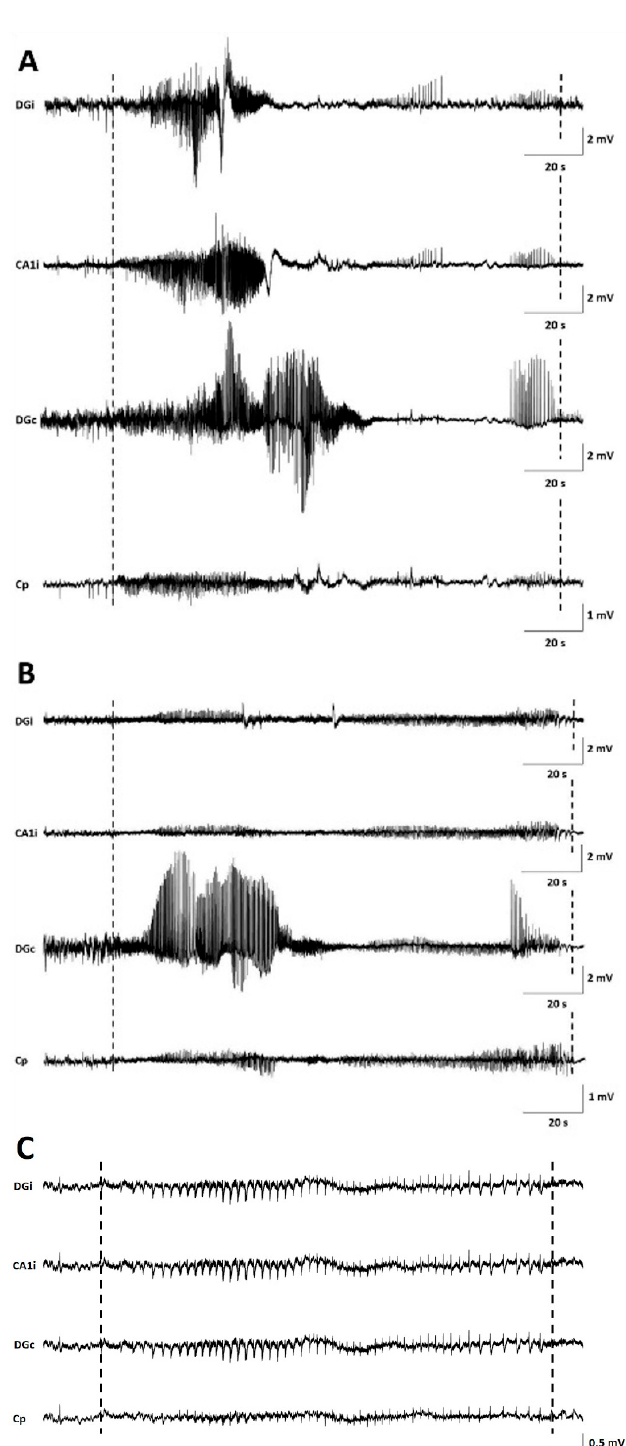
Figure 2. Examples of seizures on EEG. ( A ) representative spontaneous stage 1 seizure at PID15 in GB5. ( B ) representative spontaneous stage 1 seizure at PID20 in GB5. ( C ) representative spontaneous stage 5 seizure at PID6 in C1. Dashed lines indicate beginning and end of the seizures. The first channel represents EEG recorded from the ipsilateral dentate gyrus (DGi), the second channel EEG recorded from the ipsilateral CA1 (CA1i), the third channel EEG recorded from the contralateral dentate gyrus (DGc), and the fourth channel EEG recorded from the surface electrode at the tumor border (Cp).